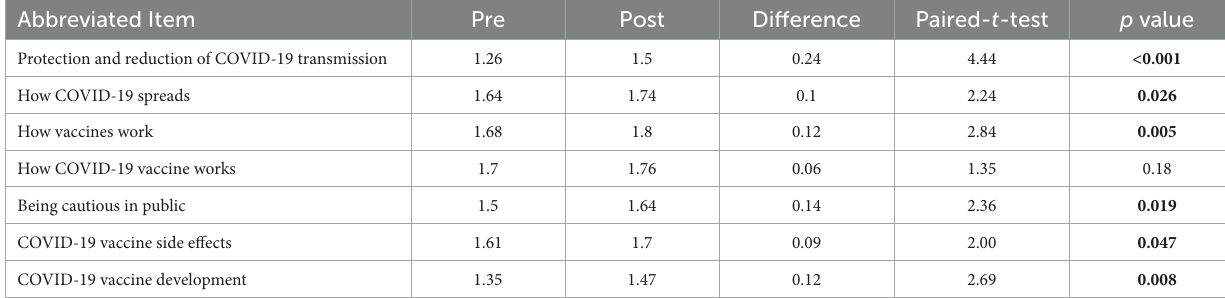
TABLE 3 Mean item virus and vaccine knowledge difference scores.